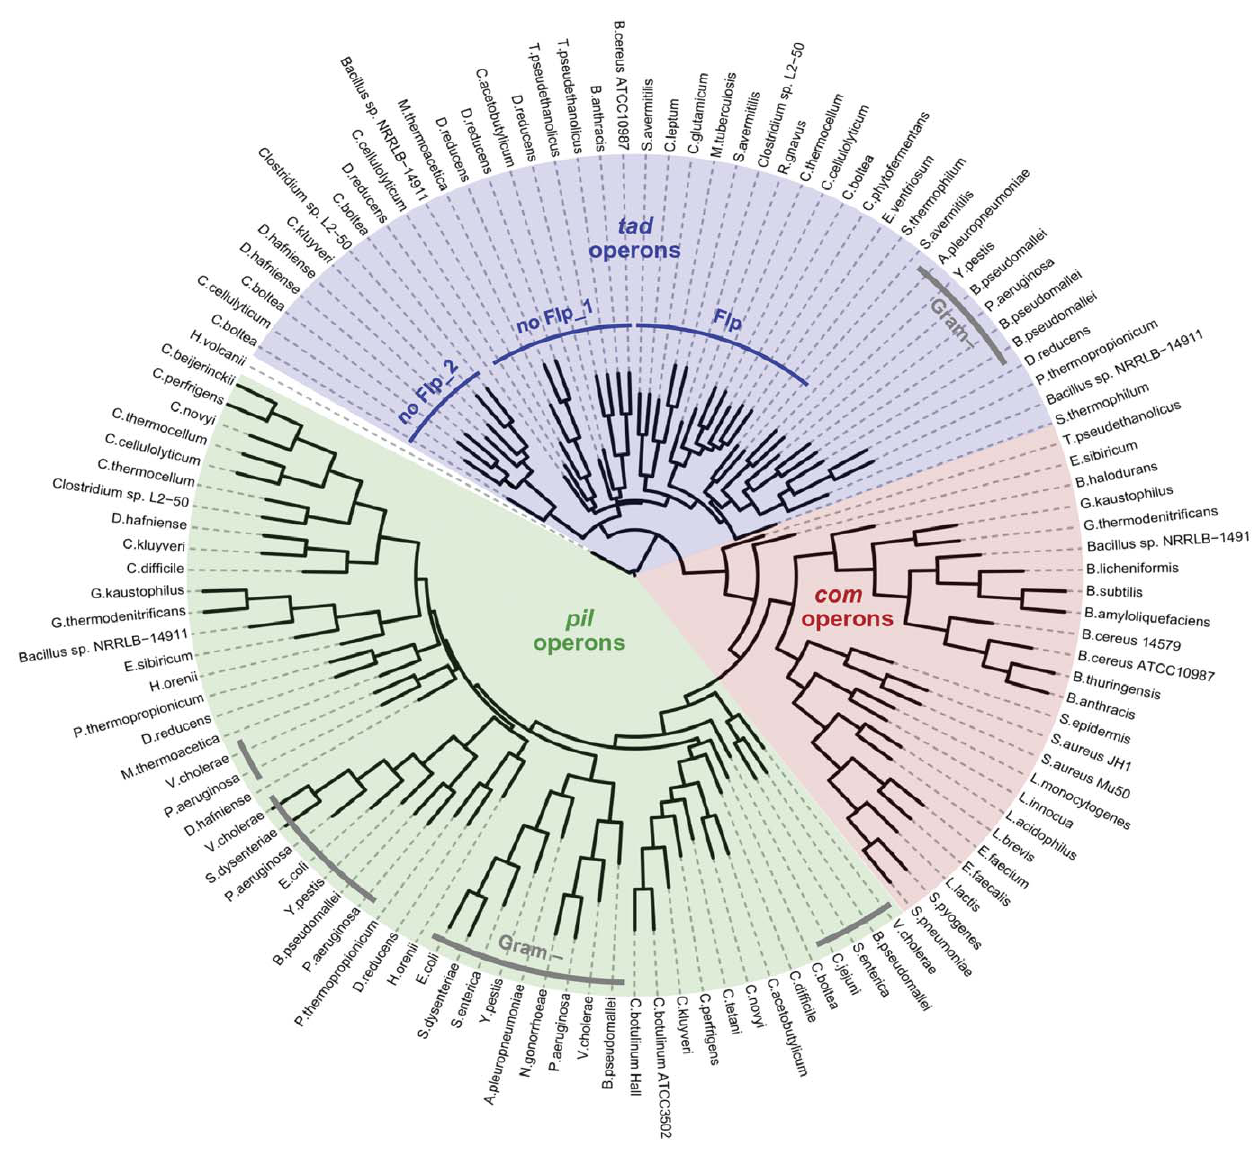
Figure 3. Phylogenetic classification of Gram-positive and Gram-Negative TFP operons. Phlyogenetic tree depicting the relationship between the three groups of TFP identified in Gram-positive and Gram-negative bacteria, based on PilB/ComGA/TadA homologs (using H. volcanii FlaI as an outgroup). Note that pil , com and tad operons form distinct clades, with Gram-negative bacteria grouped into clusters within each clade. Three distinct monophyletic groups can be identified within the tad clade, two of which encompass TFP operons that do not encode Flp pilins (no Flp_1 and no Flp_2), while the other includes all the tad operons encoding Flp pilins (Flp). Gram-negative sequences here highlighted in grey.